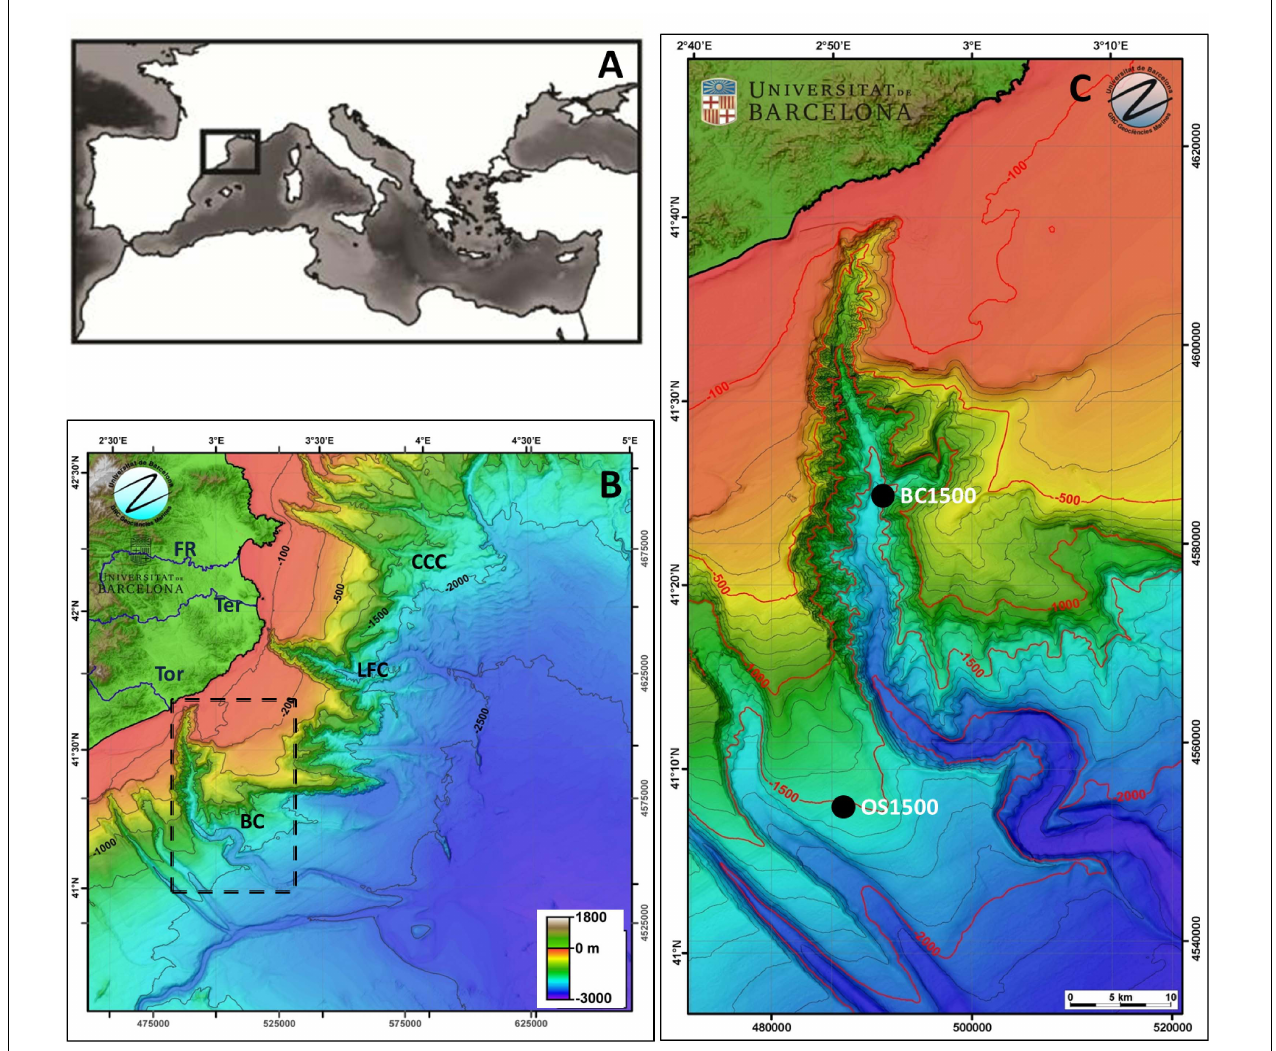
FIGURE 1 | (A) Location of the study area in the Mediterranean Sea. (B) Color bathymetric map of the study area in the North-Catalan margin. (C) Color bathymetric map and the sampling stations (white and black dots) in the Blanes Canyon region (marked with an arrow in B ). ToR, Tordera River; TeR, Ter River; FR, Fluvià River; BC, Blanes canyon; LFC, La Fonera Canyon; CCC, Cap de Creus Canyon; OS, Open slope. Color maps are redrawn from the bathymetric map of GRC of Marine Geosciences of University of